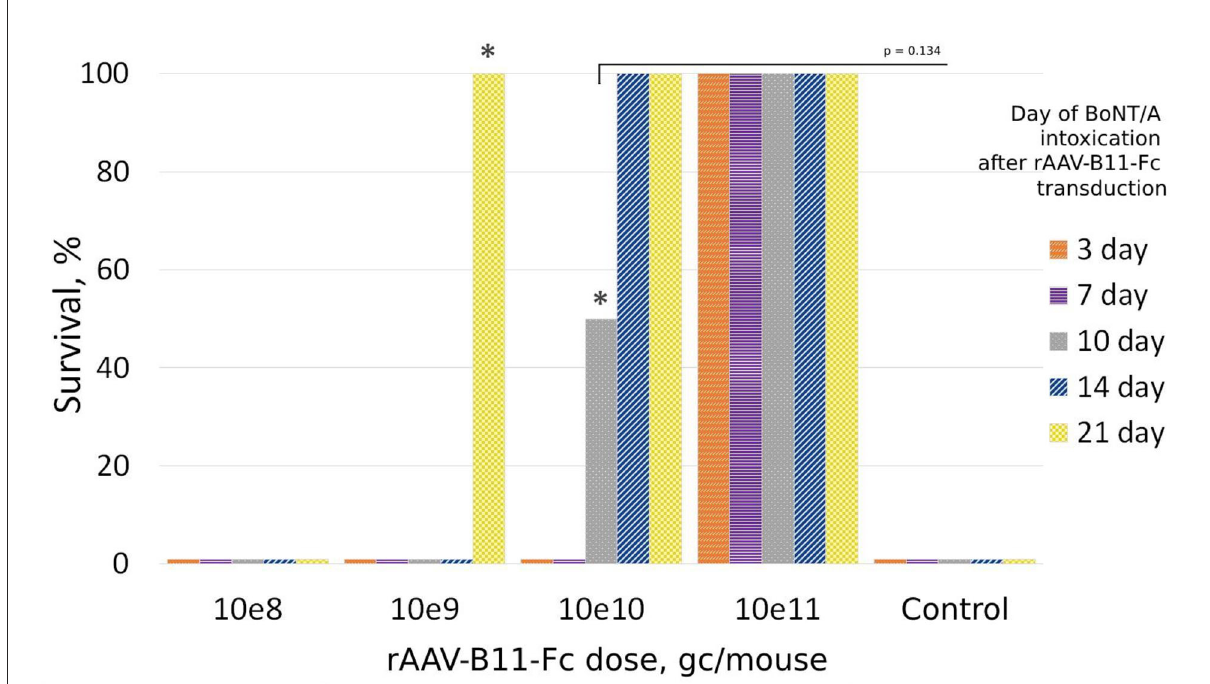
FIGURE2 Protection of mice treated with rAAV-B11-Fc at different periods before intoxication with 10LD50 BoNT/A. Groups of 20 mice received various doses of the rAAV-B11-Fc followed by a challenge with BoNT/A at different time intervals. The bars show the percentage of survival rate. The asterisks indicate the presence of botulism symptoms in the